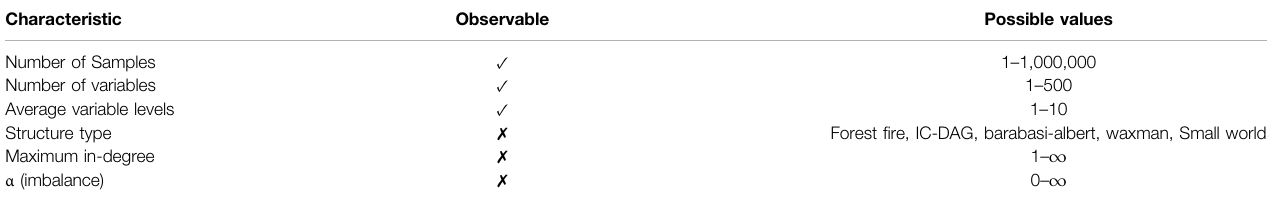
TABLE 2 | A table on the observability of the properties of BNs, as well as the values the synthetic generation tool can use. Characteristic